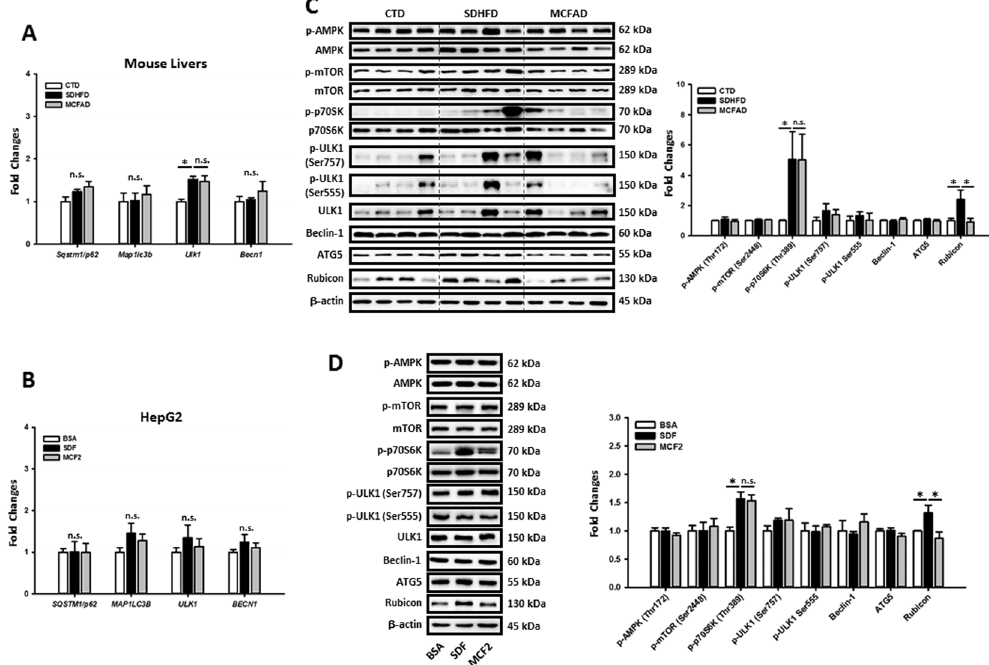
Figure 5. Increasing MCFA ratio restored hepatic autophagy by downregulating LCFA-induced Rubicon independently of regulating early-stage autophagy signaling pathways. To clarify the molecular mechanisms of MCFAs-protected autophagy, we analyzed the regulations on early-stage and late-stage autophagy signaling pathways in both mouse livers and HepG2 cells. The Sqstm1/p62, Map1lc3b, Ulk1, Becn1, SQSTM1/p62, MAP1LC3B, ULK1 , and BECN1 mRNA levels in mouse livers ( A ) and HepG2 cells ( B ) were measured using qPCR. The expression of phospho-AMPK (Thr172) phospho-mTOR (Ser2448), phospho-p70S6K (Thr389), phospho-ULK1 (Ser757), phospho-ULK1 (Ser555), Beclin1, ATG5, and Rubicon in HFD-fed mouse livers ( C ) and fat-loaded HepG2 cells ( D ) are analyzed using Western blotting. For qPCR, Actb and ACTB mRNA levels were used as the internal controls. For densitometric analyses of Western blotting data, β -actin and total target protein (for phospho-proteins) were used as the loading controls. Values are mean ± SEM (n = 6 and 3 for in vivo and in vitro studies respectively). * P < 0.05. n.s.: no significant difference; SDF: standard fat loading mixture (0.4 mM PA + 0.4 mM OA); MCF2: MCFA-containing fat mixture 2 (0.4 mM PA + 0.2 mM OA + 0.2 mM LA). Full-length blots are presented in Supplementary Figure